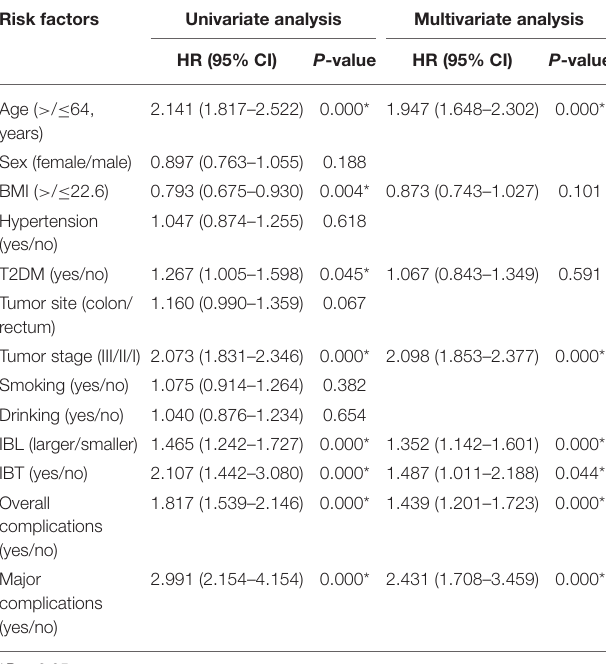
TABLE 8 | Univariate and multivariate analysis of disease-free survival. Risk